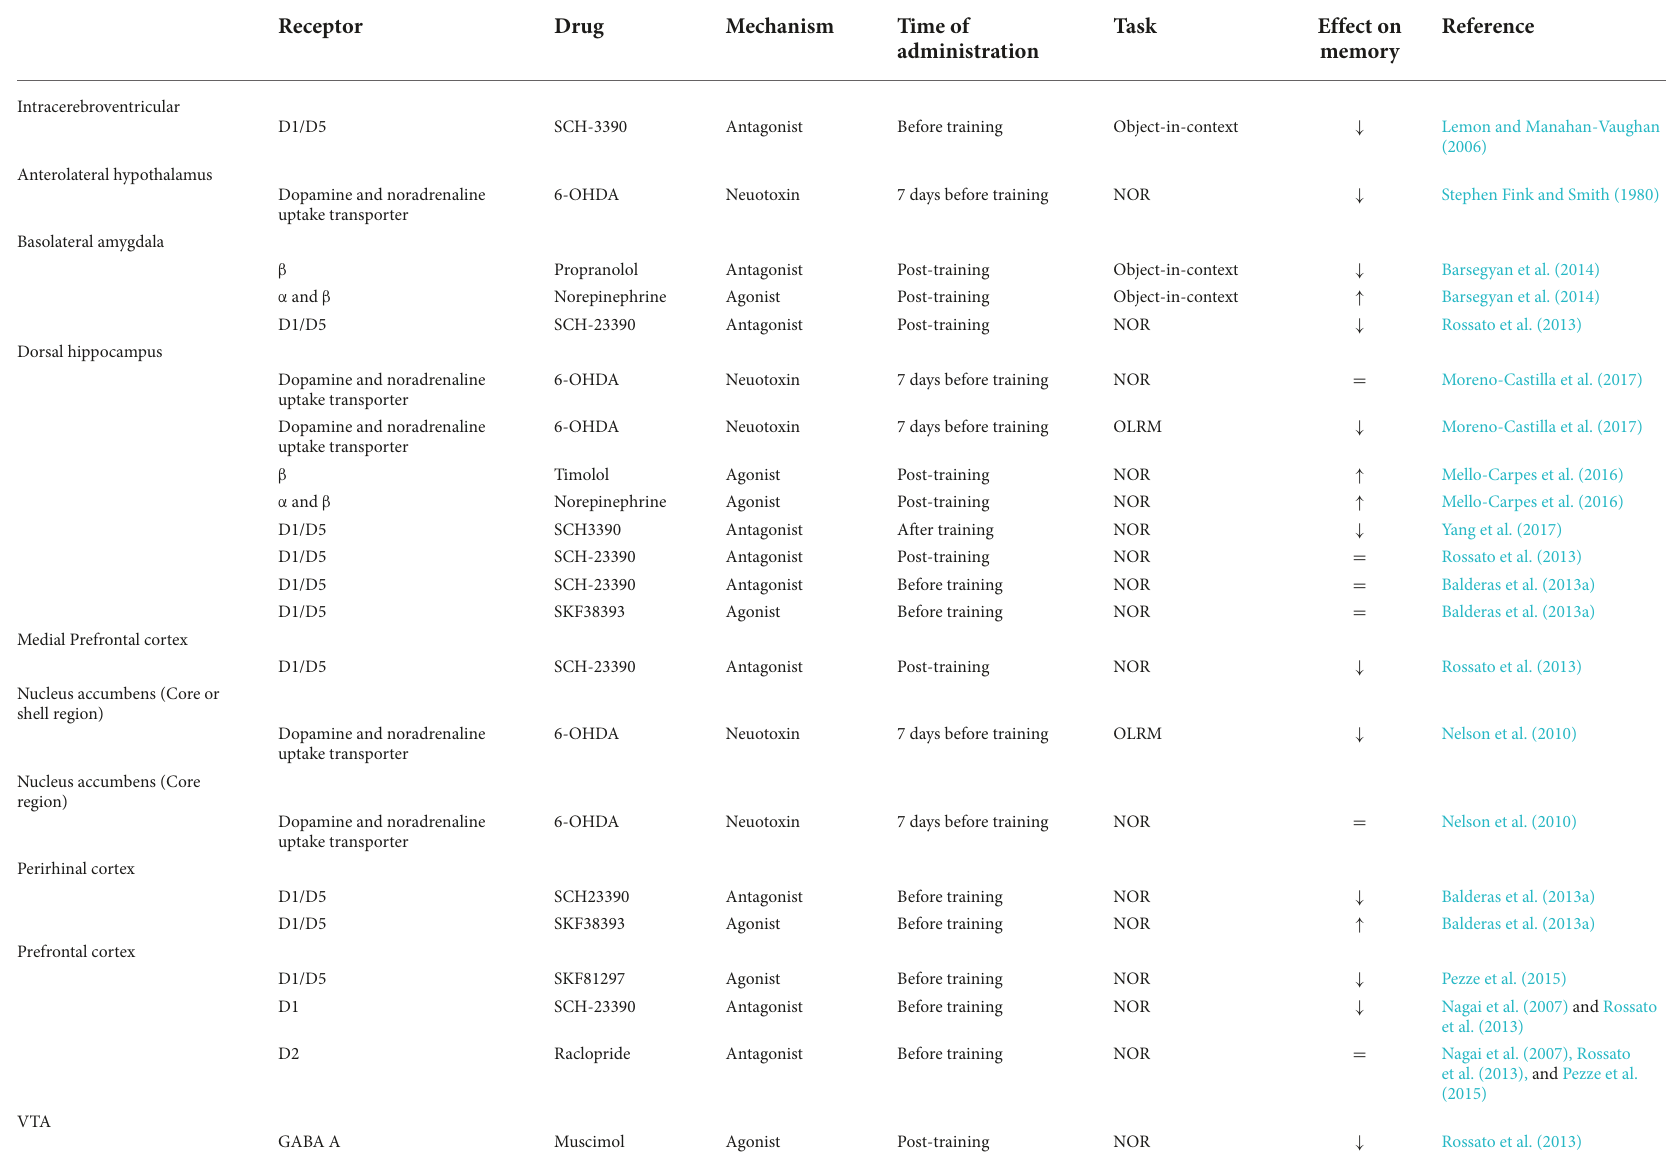
TABLE 2 Pharmacological effects of catecholaminergic drugs on NOR and OLRM performance.